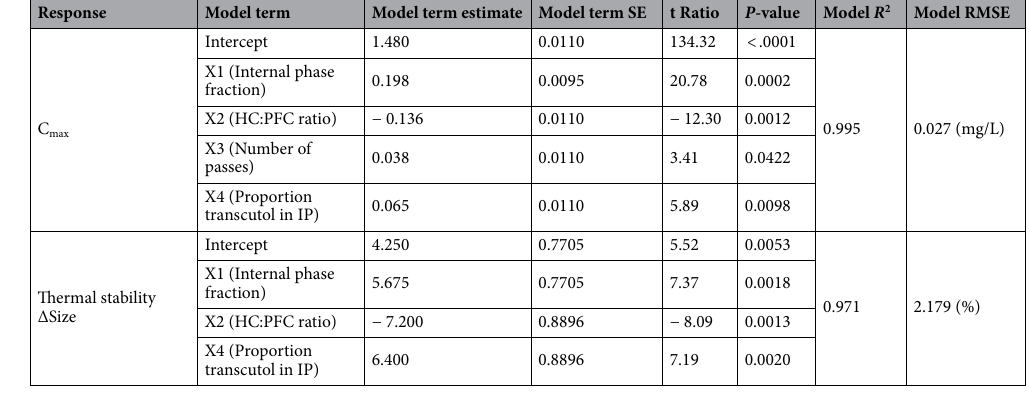
Table 4. Reduced regression model terms and goodness-of-fit for C max and thermal stability Δsize. HC hydrocarbon, PFC perfluorocarbon, IP internal phase, R 2 Coefficient of Determination, RMSE root mean square